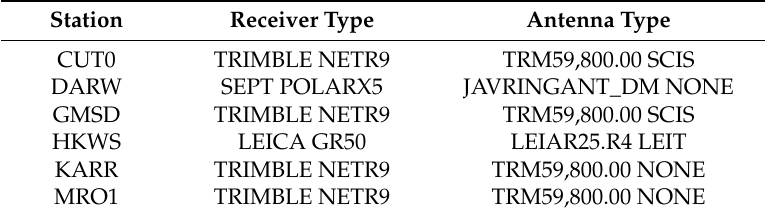
Figure 2. Distribution of the BDS reference network and user test stations. The blue triangles denote the reference stations used for FCB estimations; the red stars denote the user stations used for investigating the performance of the proposed CMB model. Table 2. Site information of six user stations. The information includes the name, receiver type, antenna